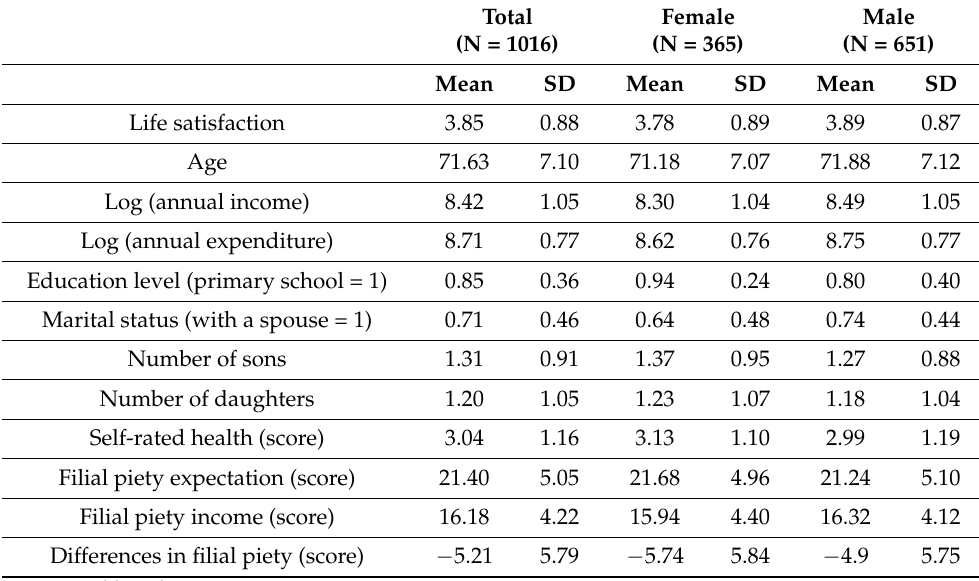
Table 1. Descriptive statistics of main